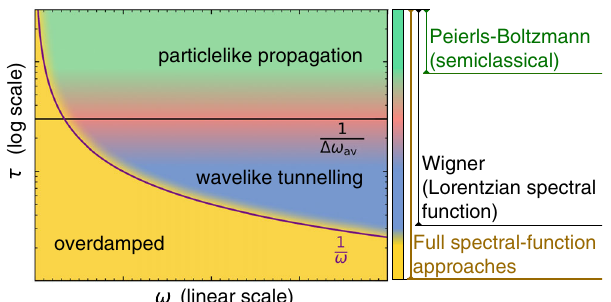
FIG. 7. Regime diagram for thermal transport. Three regimes can be distinguished in a diagram reporting the phonon lifetime ( τ ) as a function of the phonon frequency ( ω ). The horizontal black like is the Wigner limit in time, τ ¼ 1 = Δ ω (i.e., the av inverse average interband spacing, see Eq. (52), and denotes the center of the nonsharp particle-wave crossover for phonons. The green region well above the line represents phonons that propagate particlelike and mainly contribute to the populations conductivity; the blue region below the line represents phonons that tunnel wavelike and mainly contribute to the coherences conductivity; the red points around the line are phonons that contribute simultaneously and comparably to the particlelike and wavelike conductivities. The purple line τ ¼ 1 = ω is the center of the nonsharp Ioffe-Regel limit in time [41,122]. The region above it represents well-defined phonons; the Wigner transport equa- tion (37) describes all these phonons (blue, red, green), while the semiclassical Peierls-Boltzmann equation accounts only for phonons that propagate particlelike (green). The yellow region below the Ioffe-Regel limit represents overdamped phonons, which require full spectral-function approaches [78,79] to be described